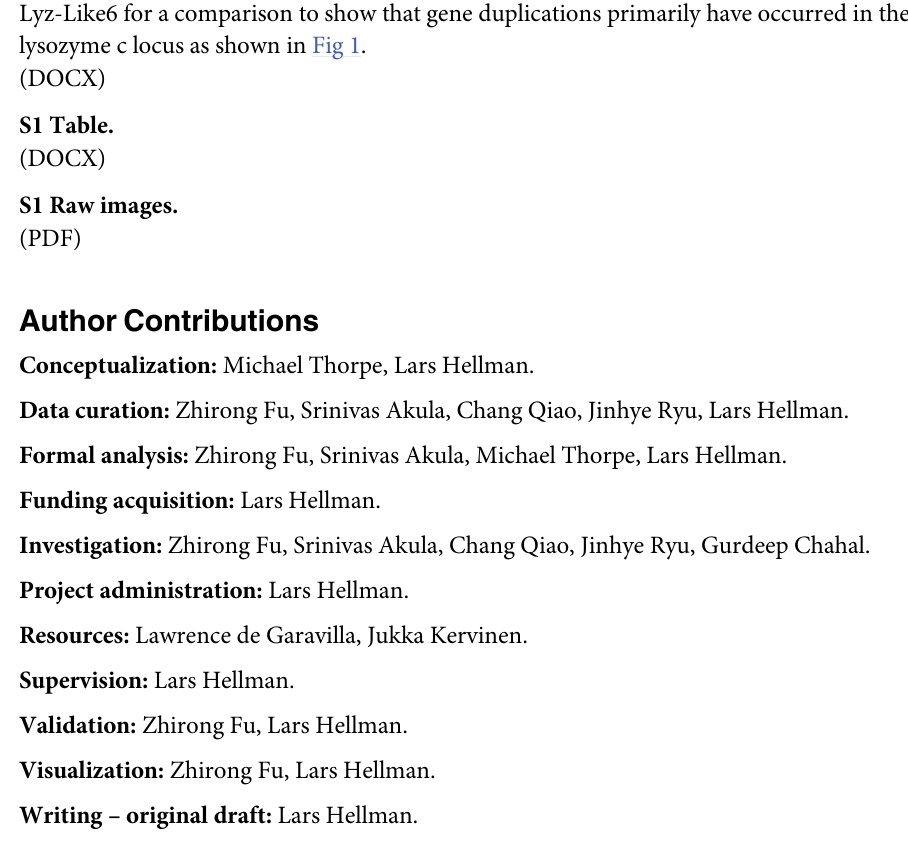
S1 Fig. Analysis of the chromosomal loci for several additional lysozyme c related genes. We here show the loci of three additional lysozyme c related genes, LysL1, LysL4-Like and Lyz-Like6 for a comparison to show that gene duplications primarily have occurred in